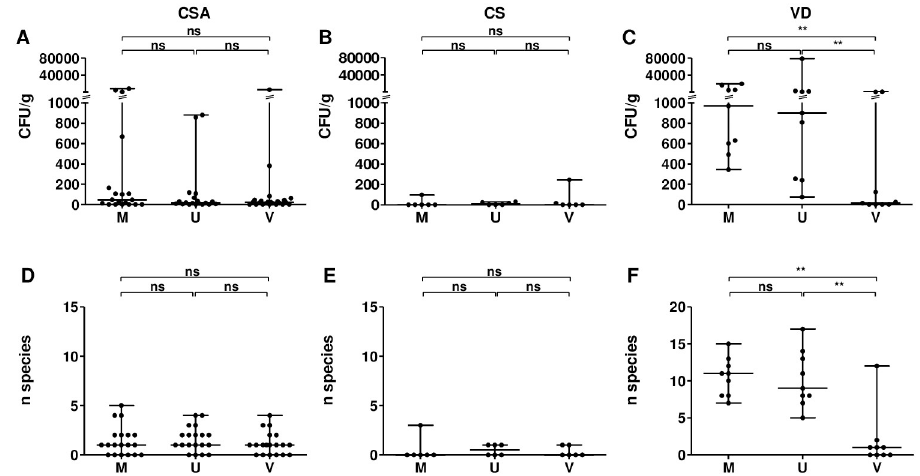
Fig 1. Quantity of bacteria (A-C) and number of different species (D-F) found in fetal membranes, umbilical cords and chorionic villi collected after cesarean section using an Alexis 1 (CSA group; A, D), cesarean section (CS group; B, E) or vaginal delivery (VD group; C, F). CFU: colony forming unit; CSA: cesarean section using an Alexis 1 ; CS: cesarean section; VD: vaginal delivery; M: fetal membranes; U: umbilical cord; V: chorionic villi. ns: non- significant; � : P < 0.05; �� : P <